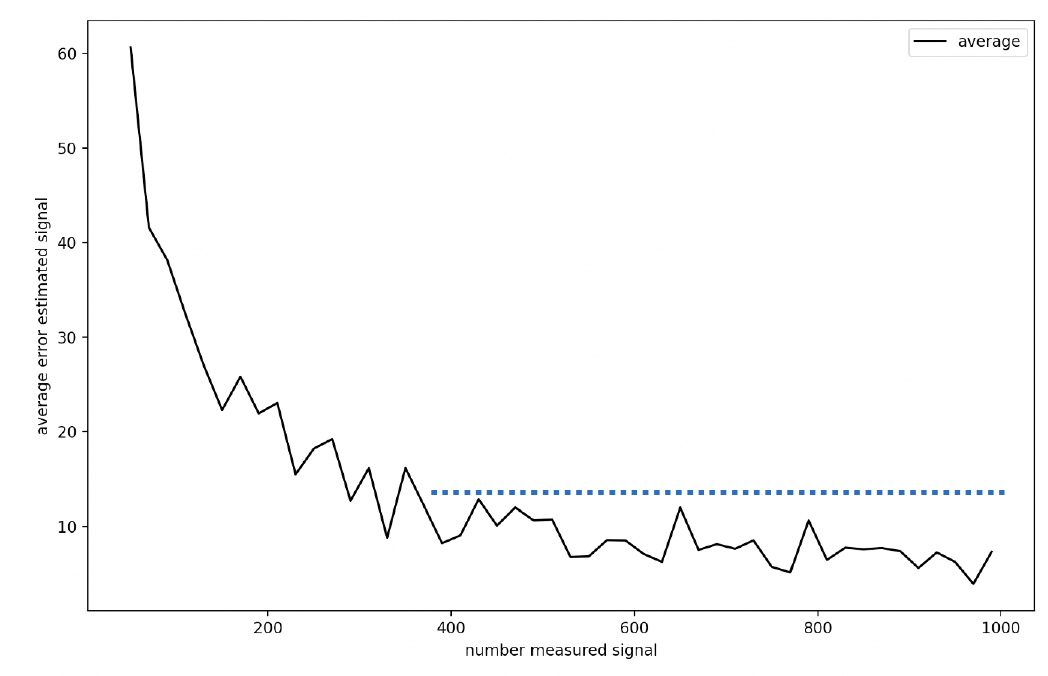
Figure 12. Influence of the number of measured signals on the estimated signal